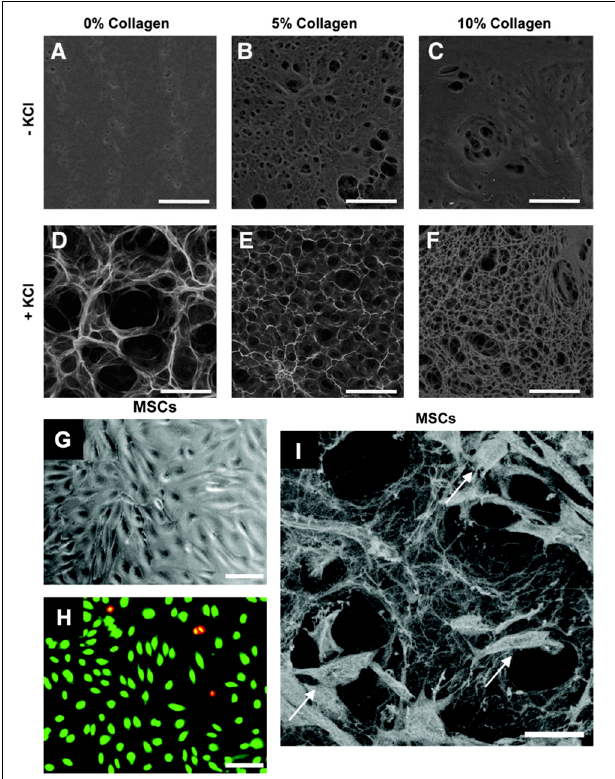
FIGURE 5 | Pullulan-collagen hydrogel can be easily modified across a wide range of factors and provides biocompatibility with stem cells. (A–F) Scanning electron microscopy (SEM) imaging demonstrates that varying collagen and KCl concentrations significantly alters the porosity of the hydrogels. Hydrogels fabricated with KCl showed increased porosity, while increasing collagen concentrations decreased porosity. Scale bar 100 µ m. (G,H) Brightfield imaging and fluorescent imaging of live (green) dead (red/yellow) stain shows successful in vitro cellular incorporation of MSCs in the hydrogels. Scale bar 50 µ m. (I) SEM shows MSCs (arrows) viably incorporated within the pullulan-collagen hydrogels. Scale bar 25 µ m. Figures adapted with permission from Figures 2, 6 of Wong et al.